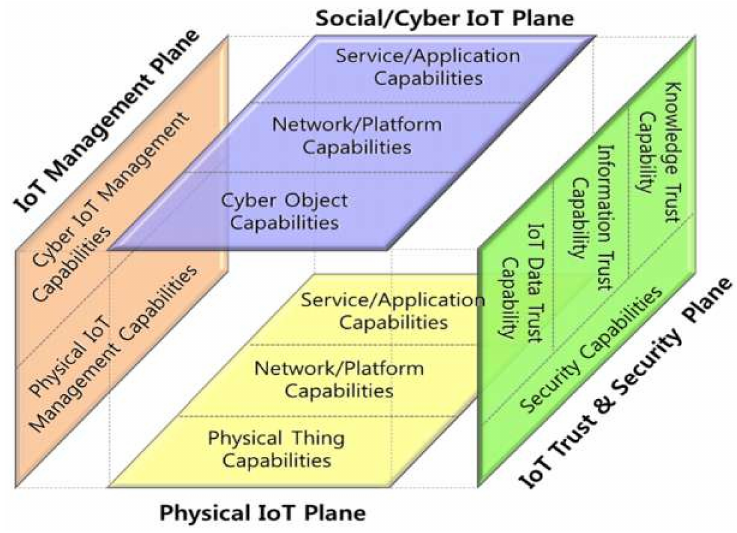
Figure 3. Generic IoT trust reference model and related